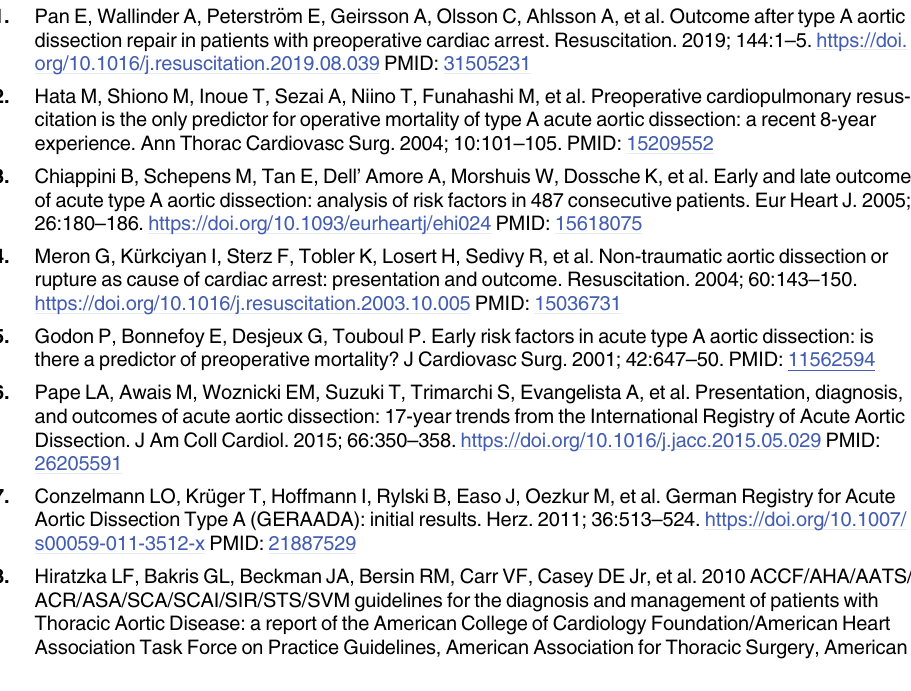
S1 Table. Preoperative characteristics and surgical information in non-matched patients of the non-CPR and CPR groups. S2 Table. Preoperative characteristics and surgical information in propensity-matched patients of the non-CPR and CPR groups. S3 Table. Postoperative mortality and morbidity in propensity-matched patients of the non-CPR and CPR